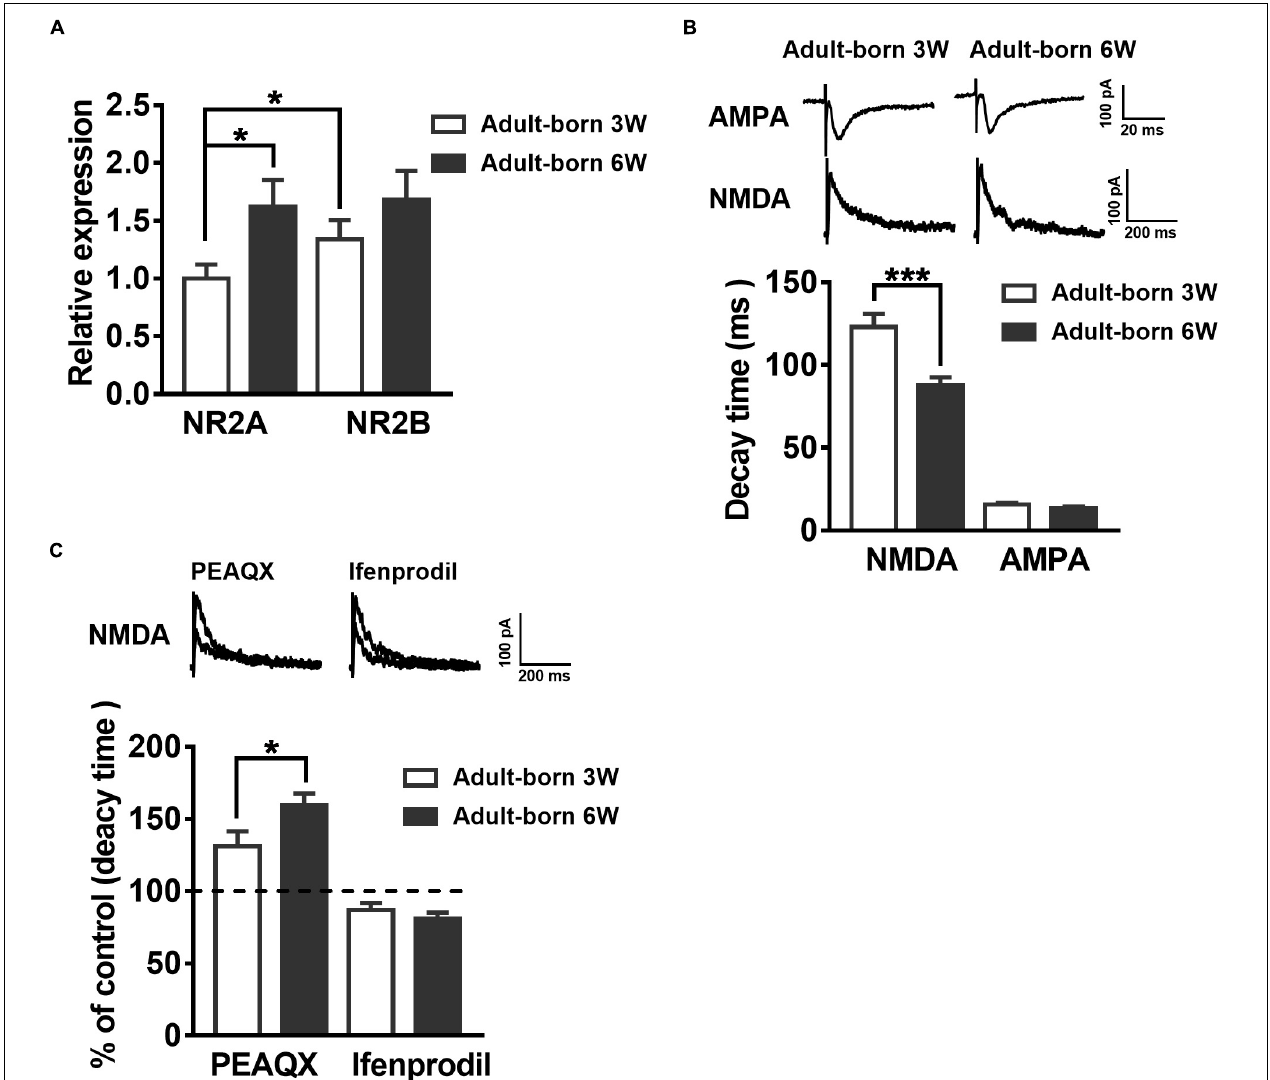
FIGURE 3 | Developmental alterations in NMDAR subunit composition in adult mouse newborn DGCs. (A) NR2AR and NR2BR mRNA relative expression in newborn 3-week-old and 6-week-old DGCs of adult mice. Values represent the mean ± SEM ( ∗ p < 0.05; t -test). (B) The AMPA- and NMDA-mediated